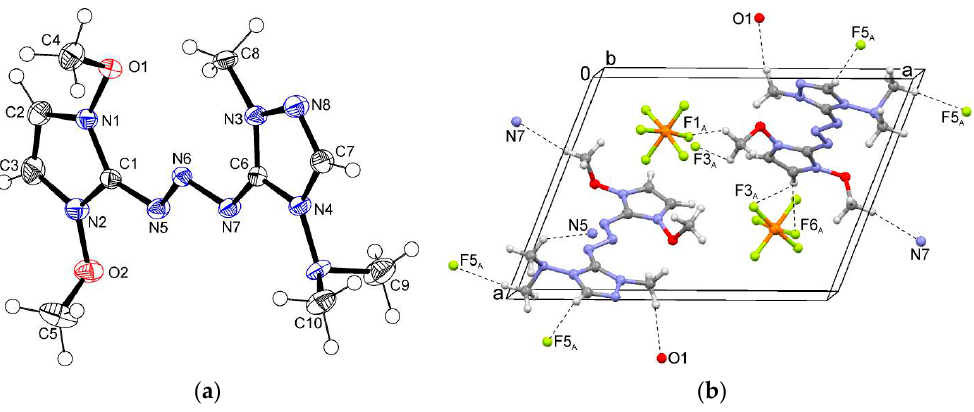
Figure 4. ( a ) Molecular structure of the cation; ( b ) interactions in the crystal structure of 3 .